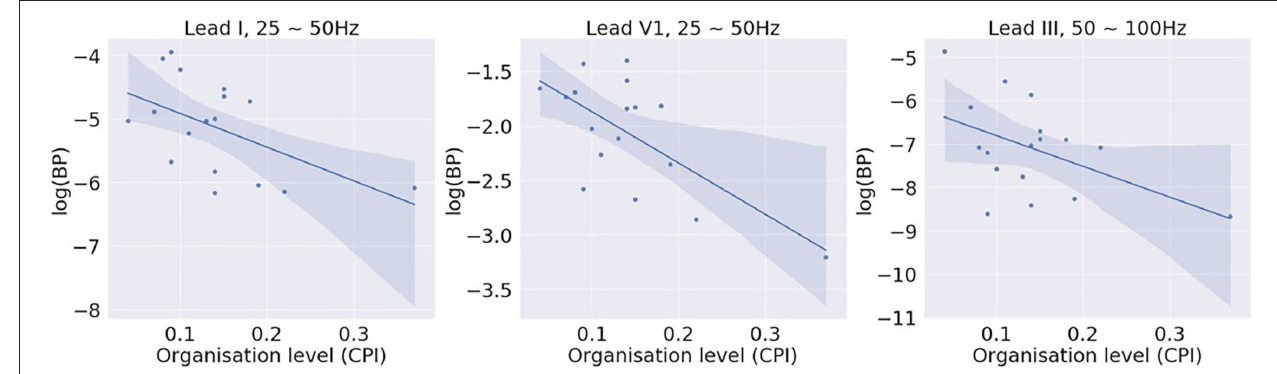
FIGURE 5 | Correlation between log (band power) of different bands and the global fibrillatory organisation level measured with causal pairing index (CPI). Significant correlations were found for higher frequency bands 25 ∼ 50 Hz and 50 ∼ 100 Hz with certain leads.